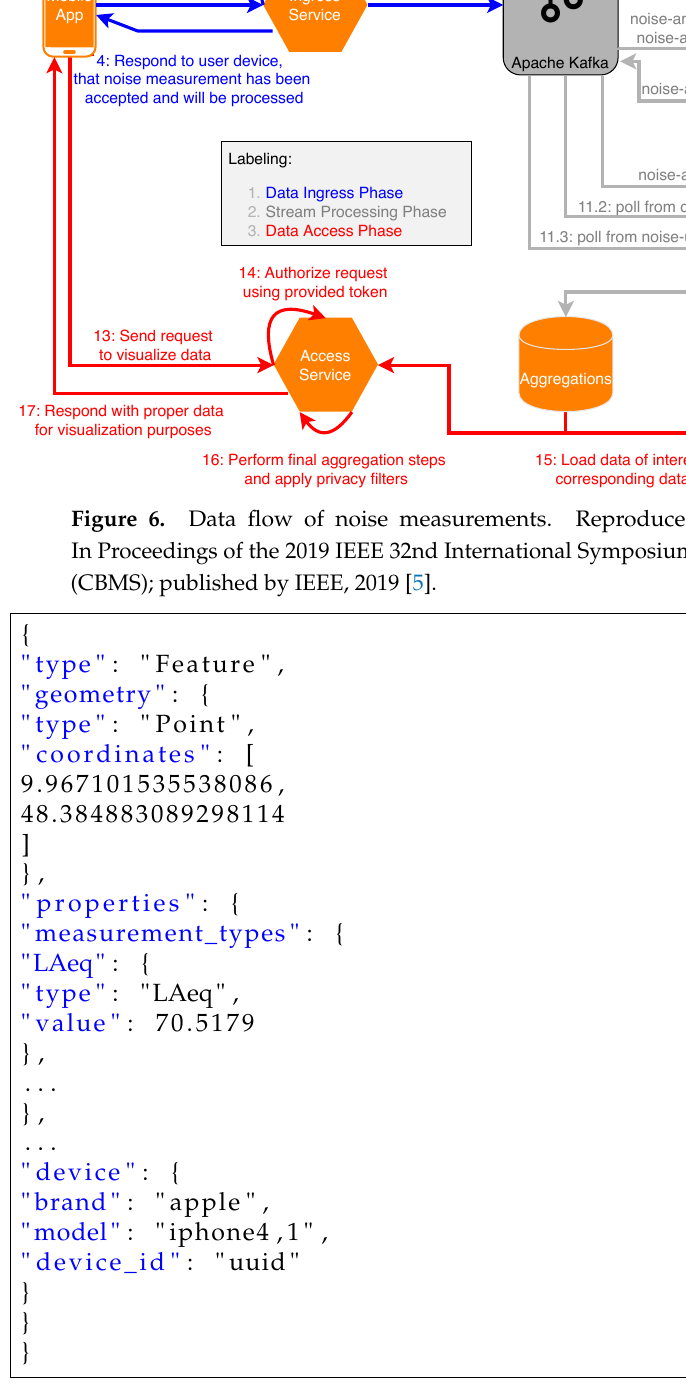
Figure 7. Example GeoJSON object that is sent to the ingress